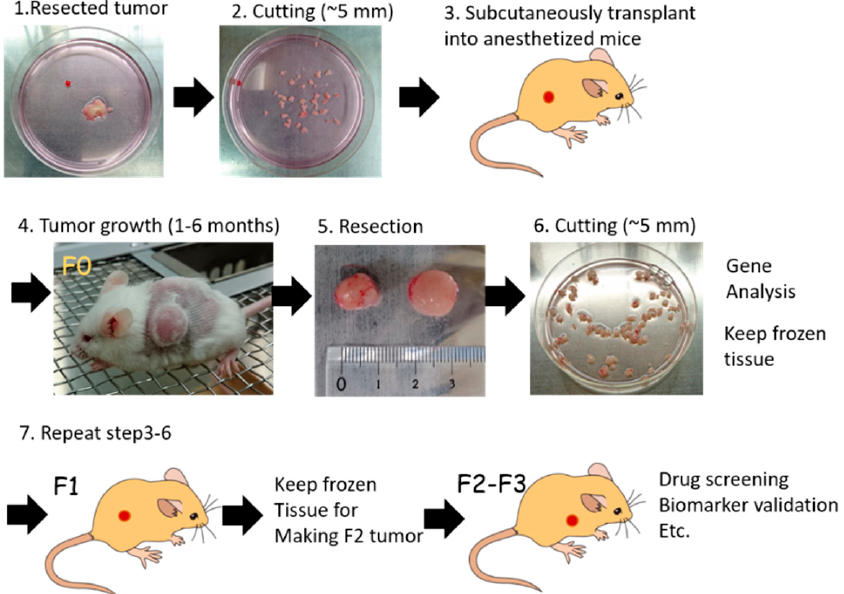
Figure 5. Generation process of PDX. Surgical specimen from a patient’s tumor (1) is divided into small pieces (2) and transplanted into an anesthetized immunocompromised mouse (3). Tumor growth takes 1 to 6 months (4). Once tumors are grown in F0 mice, xenografts are resected (5) and cut into small pieces (6). Parts of tumor tissues are analyzed for tumor characteristics, such as whole exome sequencing (WES), RNA sequencing (RNA-seq), and copy number variation (CNV) analysis. The remnant PDX tumor is stored in liquid nitrogen, or further transplanted into immunocompetent mice (7) for expansion. Conventionally, F2 or F3 PDX tumors are used for cancer biology study, such as drug sensitivity screening, identifying biomarkers, etc.